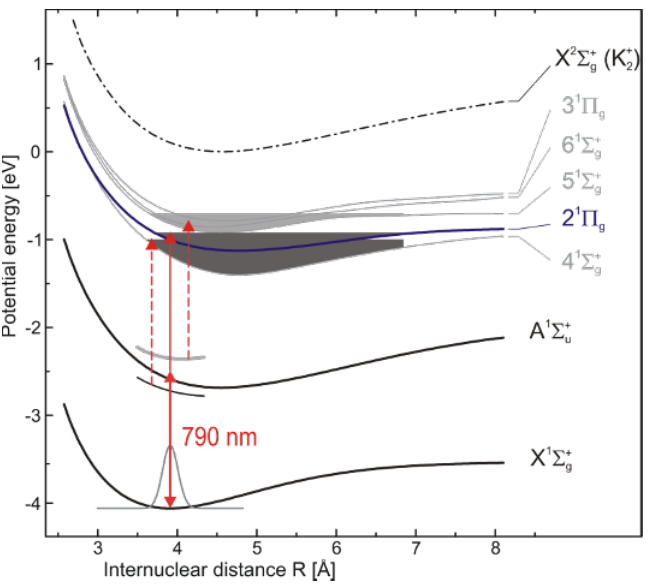
Fig. 1. Scheme for selective excitation of K 2 with shaped 790 nm 25 fs (Full-Width-Half- Maximum-duration) laserpulses (photon arrows). The pulses have a peak intensity of I=8.5∙10 11 W/cm 2 . In the weak-field limit the dimer is excited perturbatively from the groundstate X 1 Σ + g via the resonant A 1 Σ + u state to the 2 1 Π g state. Resonant interaction with intense laserpulses couples the resonant states X and A efficiently and induces an electronic coherence, i.e. a molecular electronic wave packet is launched. The light-induced potentials (dark and light grey line) split up energetically and hence lower lying (dark shaded) and higher lying (light shaded) electronic target states become